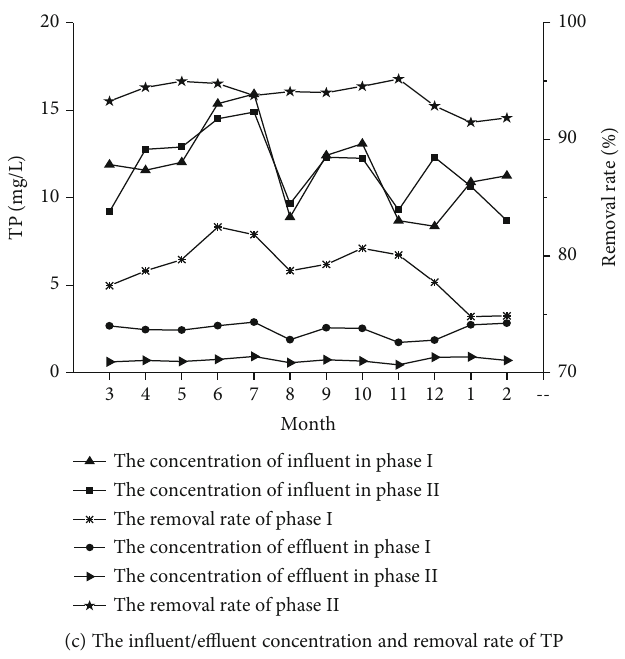
Figure 6: In and out water concentration and removal rate in two